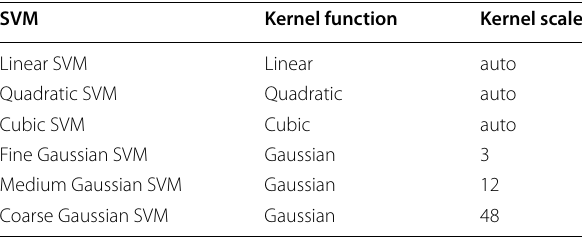
Table 1 Models and parameters of machine